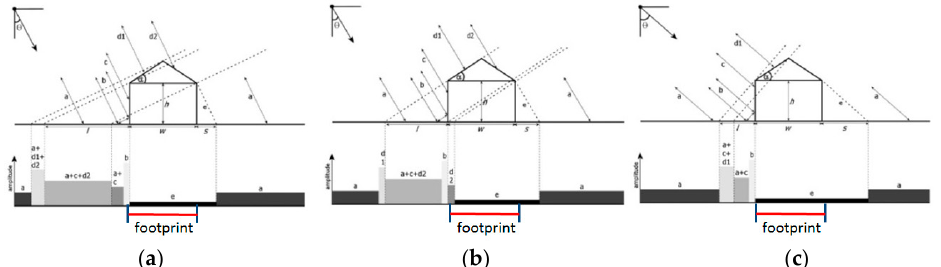
Figure 5. Backscattering range profiles from a gable roof building with roof inclination angles α . The legend is similar to that used for the flat roof buildings in Figure 3. The gray values in the backscattering profiles correspond to the relative amplitudes. ( a ) θ < α ; ( b ) θ = α ; ( c ) θ > α (re-edited from [12]).